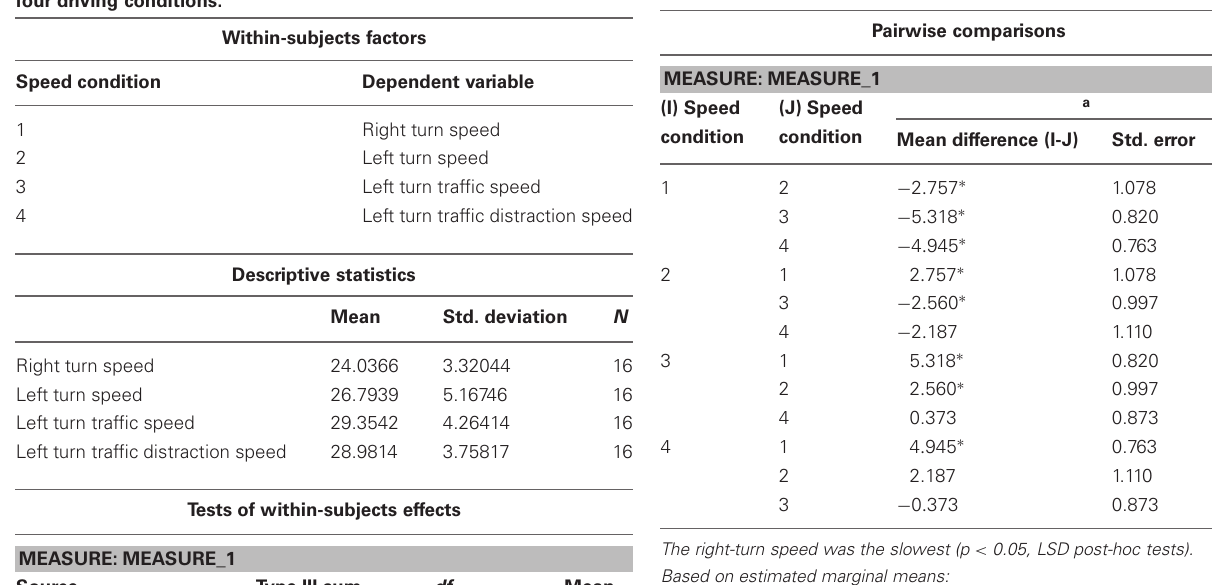
Table A2 | Post-hoc tests suggest that speed in the distracted left-turn-traffic condition was significantly slower than both the left and the right turn speed, and the left turn speed was significantly slower than the right turn